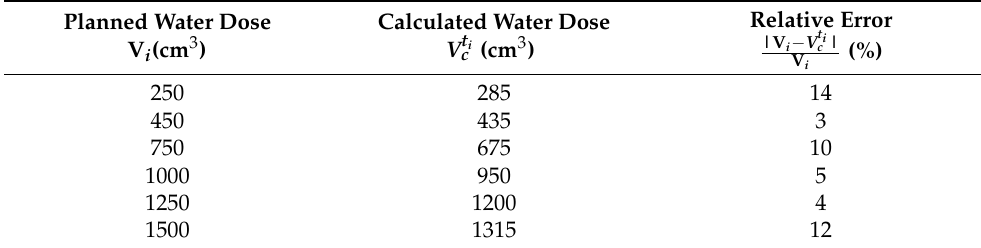
Table 1. Increase of water content at the moment of injection for the analysed water doses. Planned Water